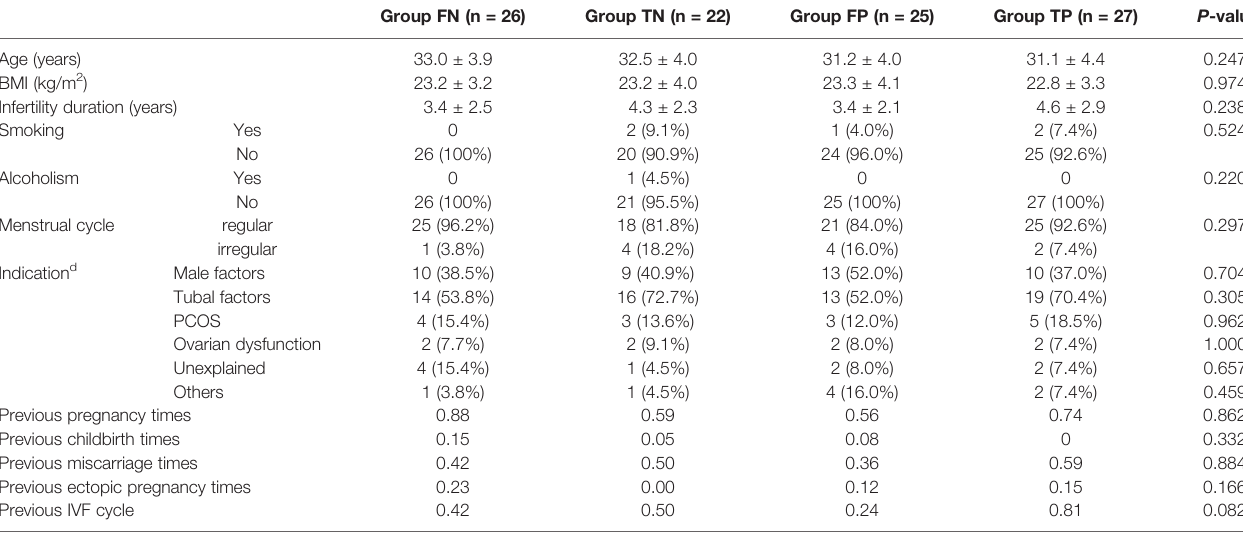
TABLE 1 | Characteristics of the